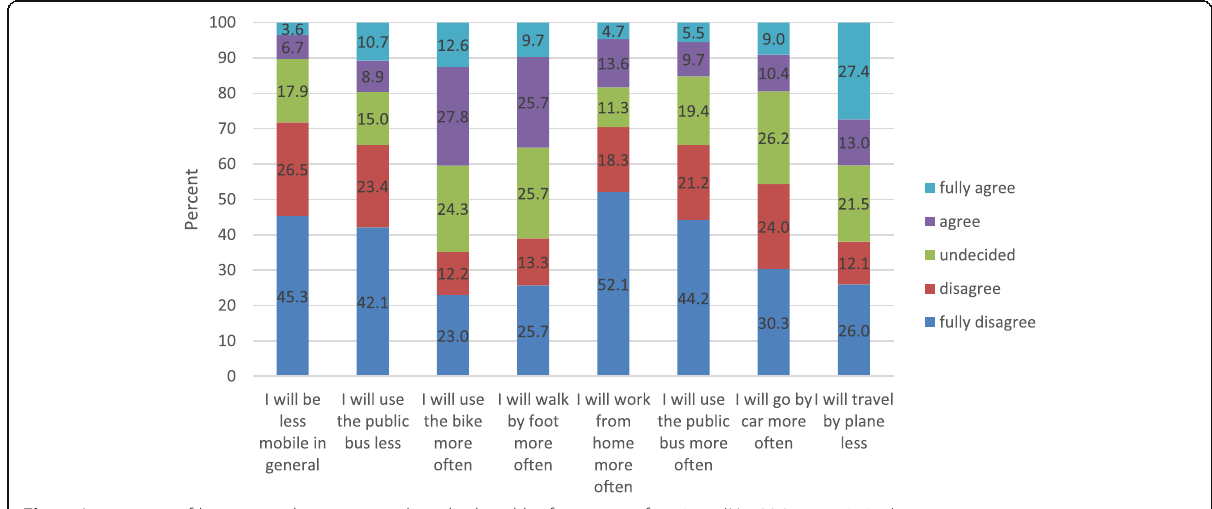
Fig. 4 Assessment of long-term changes according displayed by frequency of options ( N = 226, rest